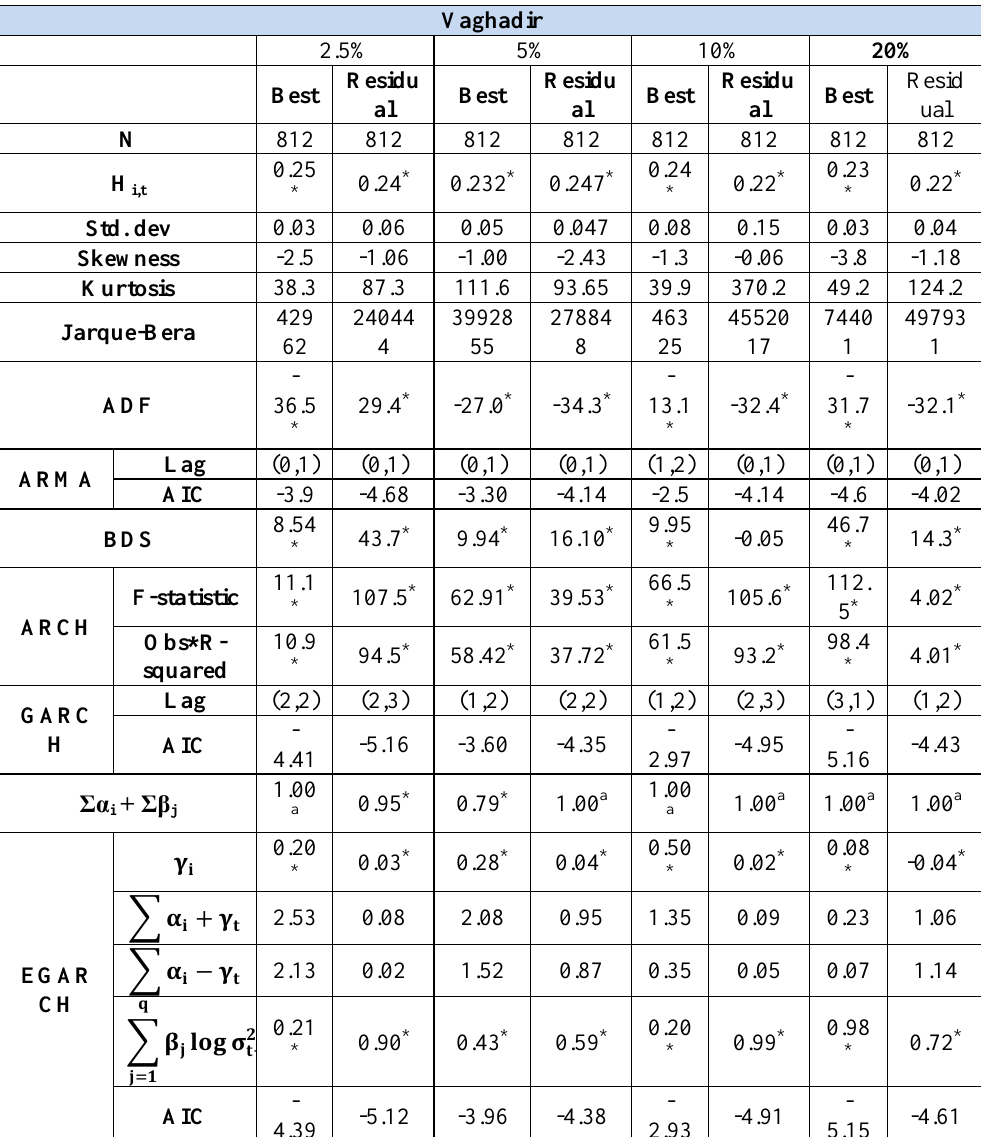
Table 6. Econometric statistics for the Vaghadir price series estimated